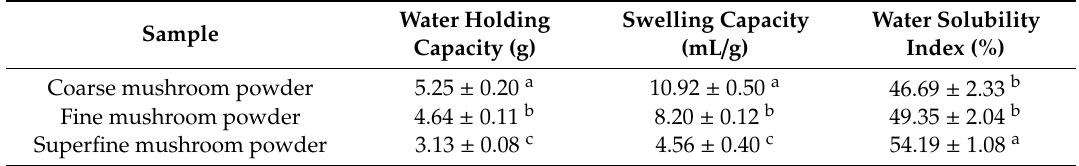
Table 4. Hydration properties of coarse, fine and superfine mushroom powders produced from white button mushrooms exposed to a 30 min UV-B treatment.